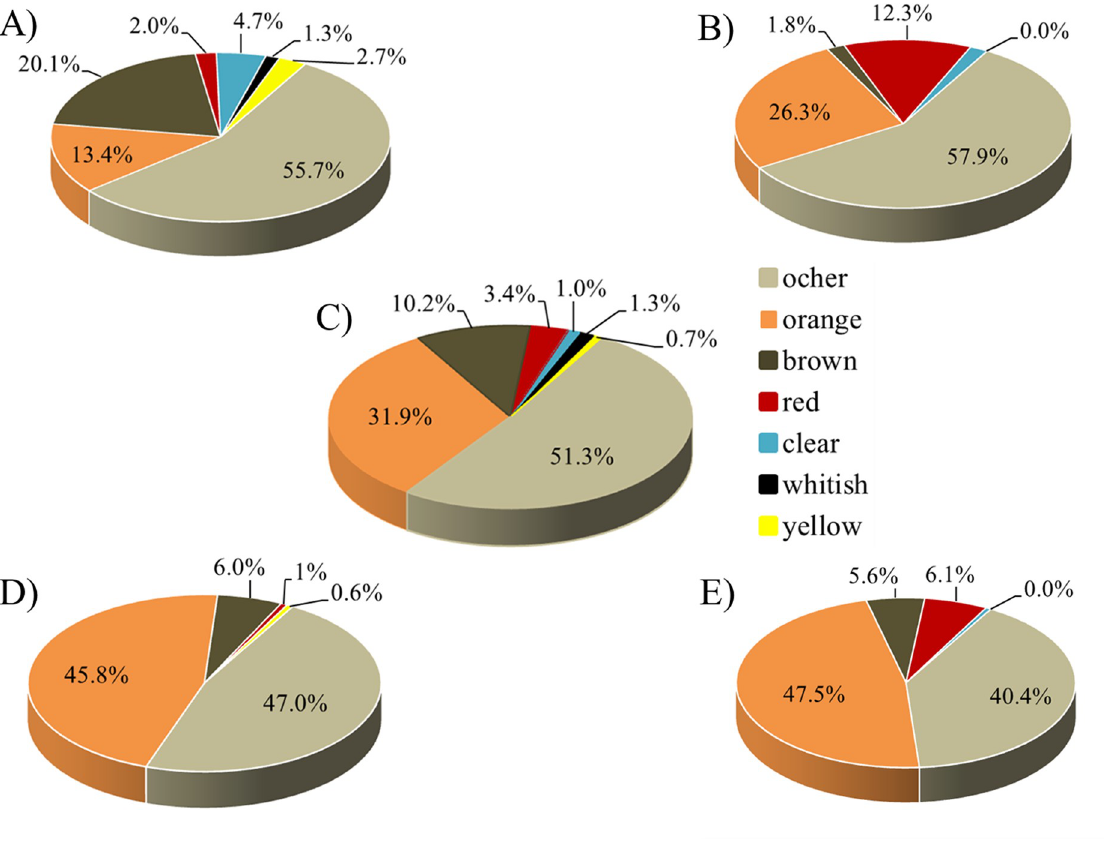
Fig 2. Percentages of different resins types collected by resin foragers from seven apiaries in Lower Saxony, Germany. C) total of foragers (N = 661), A)–E) four exemplary sites (A) site Lg (N = 149); B) site Ml (N = 57); D) site Gr (N = 168) and E) site Ol (N = 198)). For meaning of abbreviations and site descriptions see Table 1. Different resins types were characterized by color (i.e. “ocher”, “orange”, “brown”, “red”, “yellow” “whitish”, and “clear”) during field observations and subsequently verified by chemical analysis (via gas chromatography and mass spectrometry,